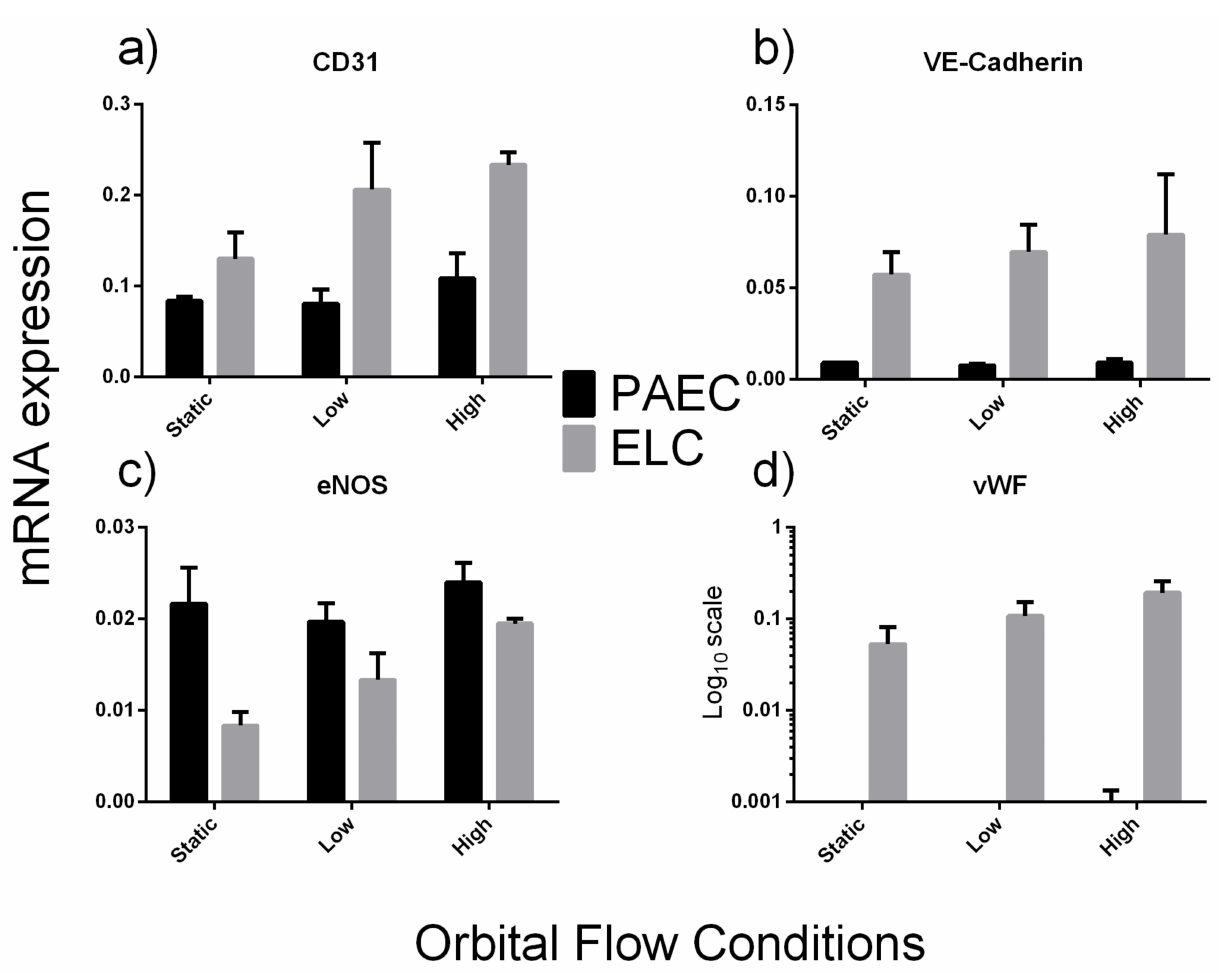
Figure 3. mRNA expression (arbitrary units) of endothelial cell markers CD31 ( a ), VE-Cadherin ( b ), endothelial nitric oxide synthase (eNOS) ( c ) and von willebrand factor (vWF) ( d ) of porcine endothelial-like cells (ELC) and aortic endothelial cells (PAEC) under different flow conditions on the orbital shaker. Error bars are standard errors of the